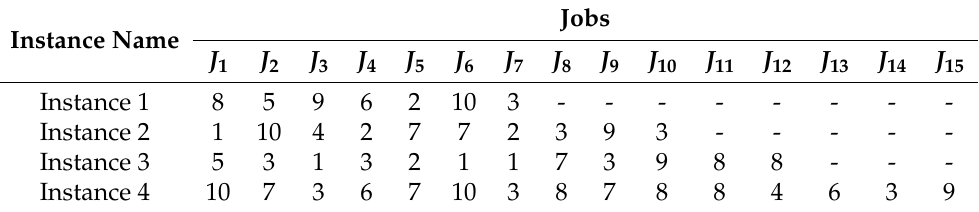
Table 5. The weight information of the job in each instance (unit: kg).